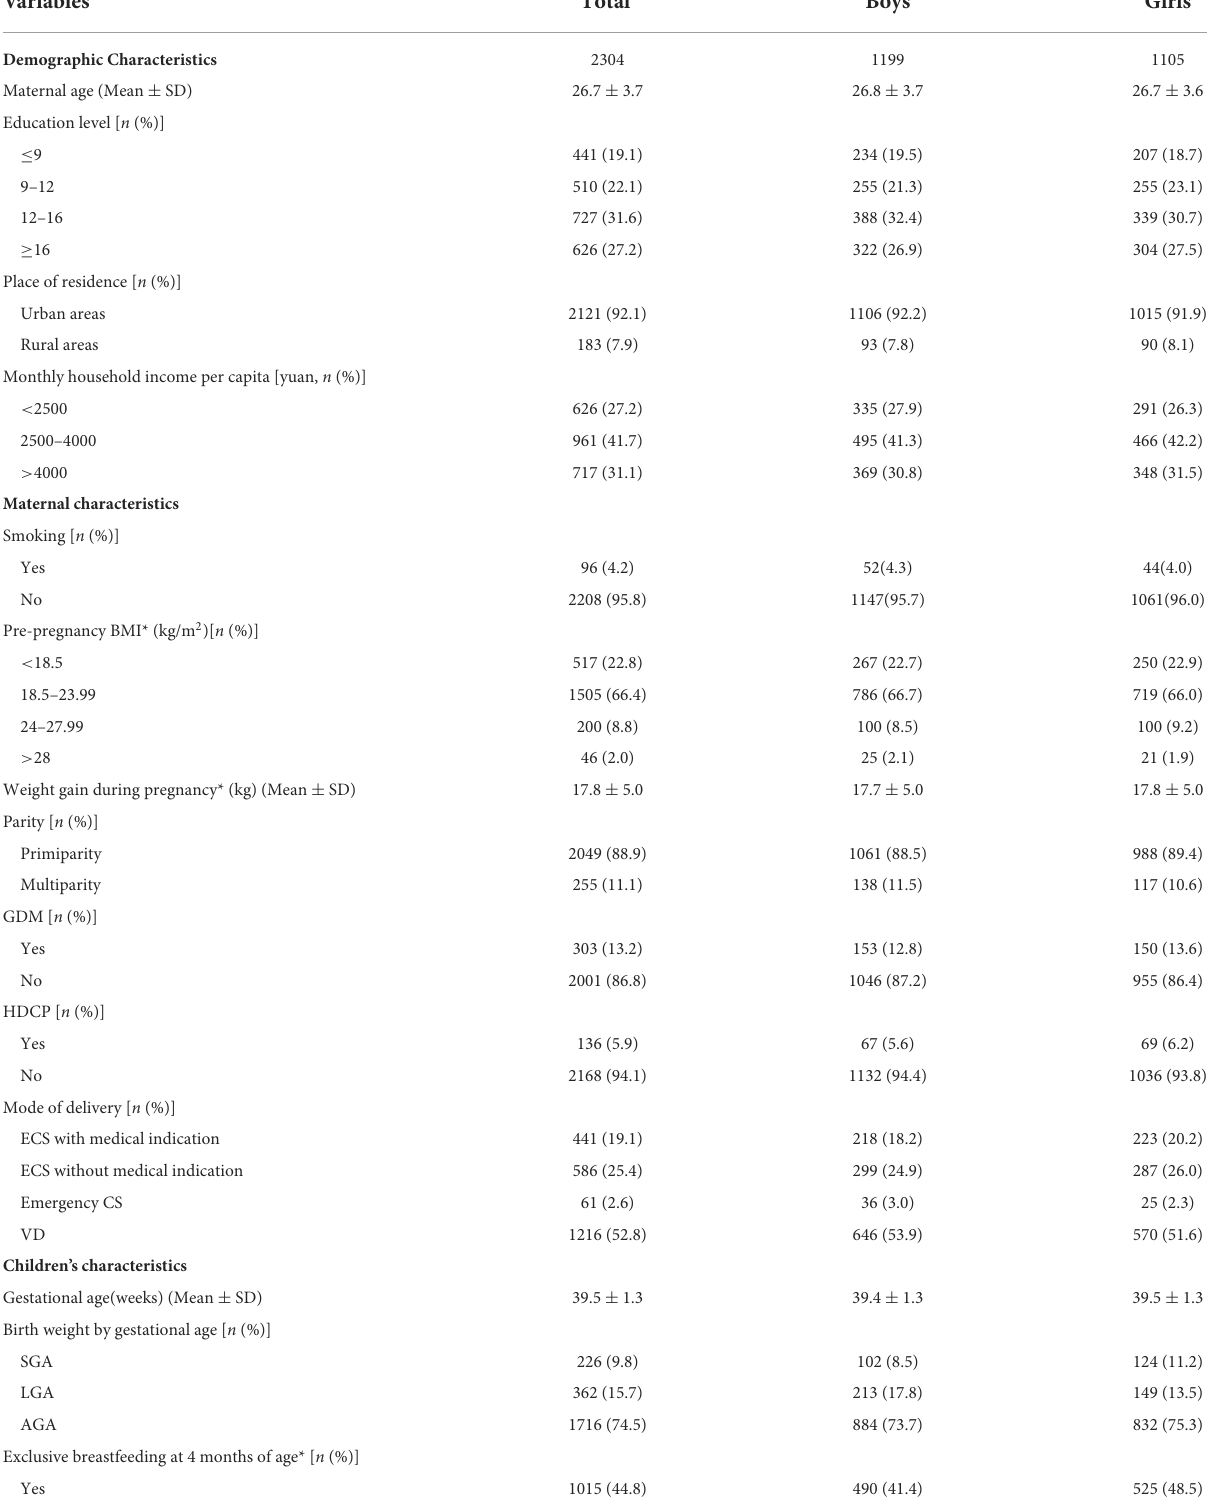
TABLE 1 Basic characteristics of participants ( n =